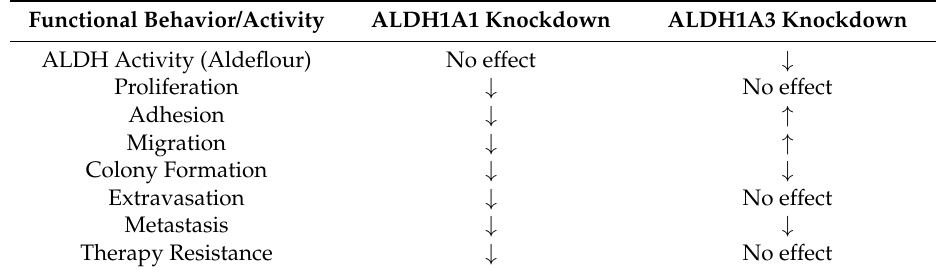
Table 1. Summary of functional consequences of ALDH1A1 and ALDH1A3 knockdown in MDA-MB-468 and SUM159 human breast cancer